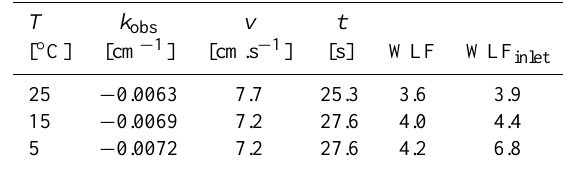
Table 1. Sulfuric acid losses in the upper half of the nucle- ation chamber at three relative humidities, RH (16, 32 and 57%), T=25 ◦ C, where k obs is the observed loss rate coefficients, v is mean flow velocity, t is residence time, WLF is the wall loss fac- tor, and WLF inlet is the wall loss factor estimated for CIMS’ inlet sampling tube.